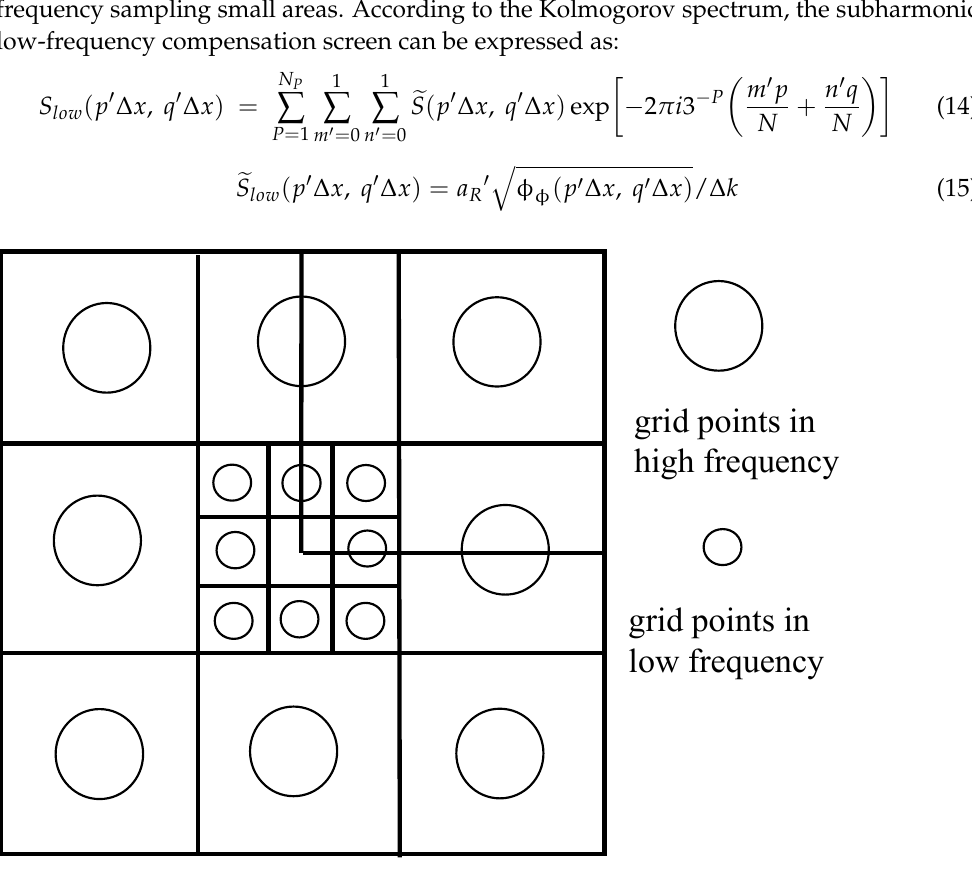
9 of 18 2.3. Low-Frequency Sampling Optimization For the simulated turbulent phase screen generated by the Fourier transform method, the range of the minimum wave number interval ∆ of the phase screen does not include (−∆  2 ， ∆  2⁄⁄ ) and −∆  2 ， ∆  2⁄⁄  , so it has the disadvantage of insufficient low frequency [31]. We use the method of adding sub-harmonics to perform low-frequency compensation on the phase screen by the Fourier transform method. In essence, the high- frequency phase screen simulated by the FFT method is interpolated and fitted to improve the statistical characteristics of low frequency. The specific process is as follows: firstly, divide the square area surrounded by the first sampling point of the low-frequency part limited to the high-frequency part into nine areas with equal area; then, set the sampling points contained in the area (including the edge part) to zero; and finally, take eight small